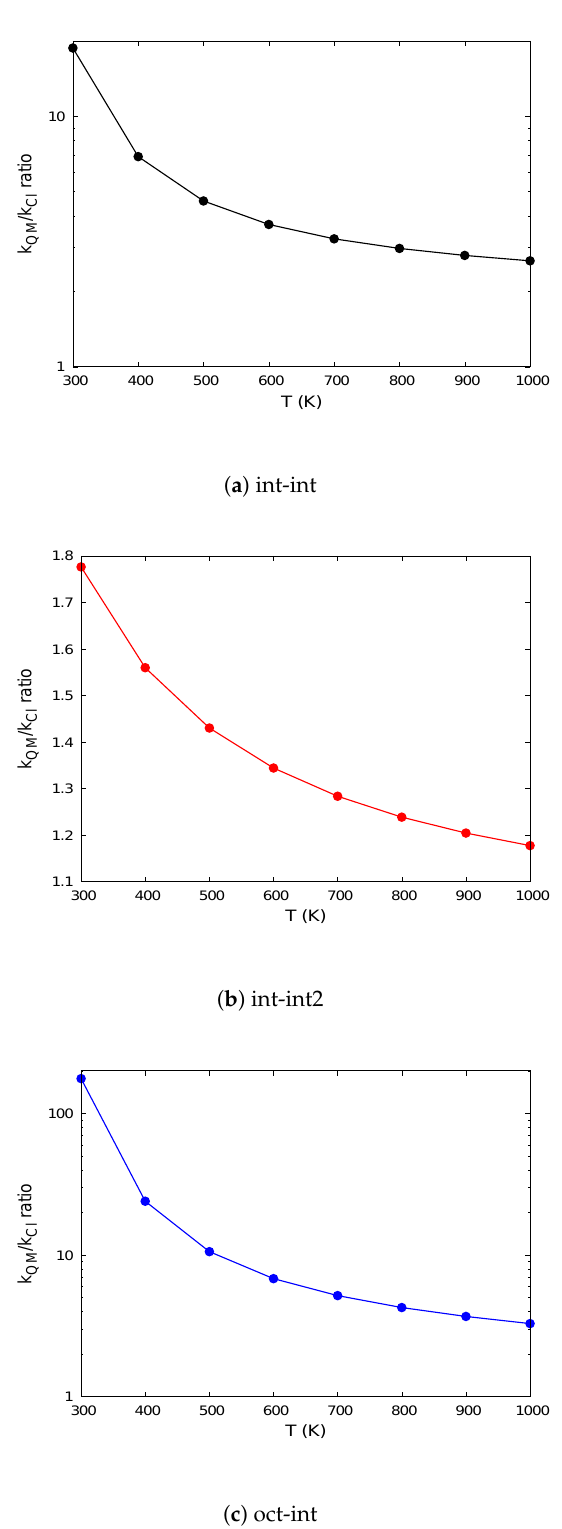
Figure 5. Ratio of the hydrogen quantum to classical diffusion rates for the three pathways investi- gated in this study. Results for int-int and oct-int diffusion hops are shown on a log scale for the sake of